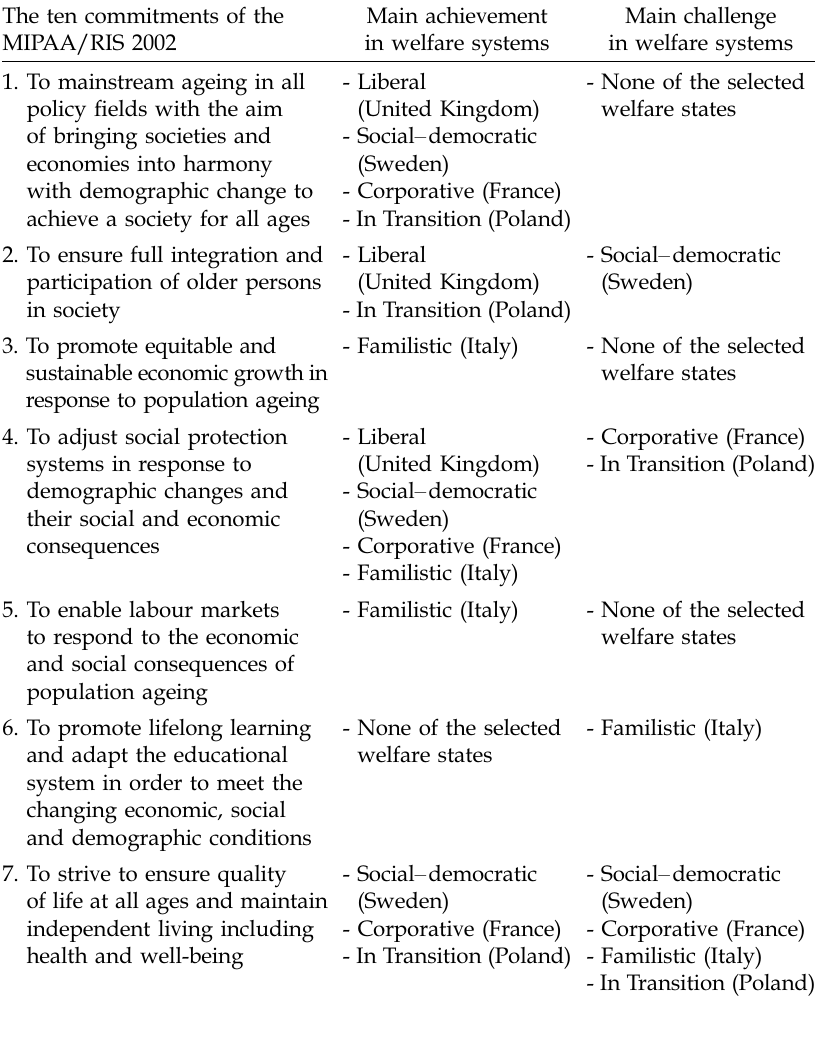
Table 2. European welfare systems and main achie v ements and main challenges in the implementation of the regional implementation strategy for the Madrid International Plan of Action on Ageing (MIPAA/RIS) 2002 The ten commitments of